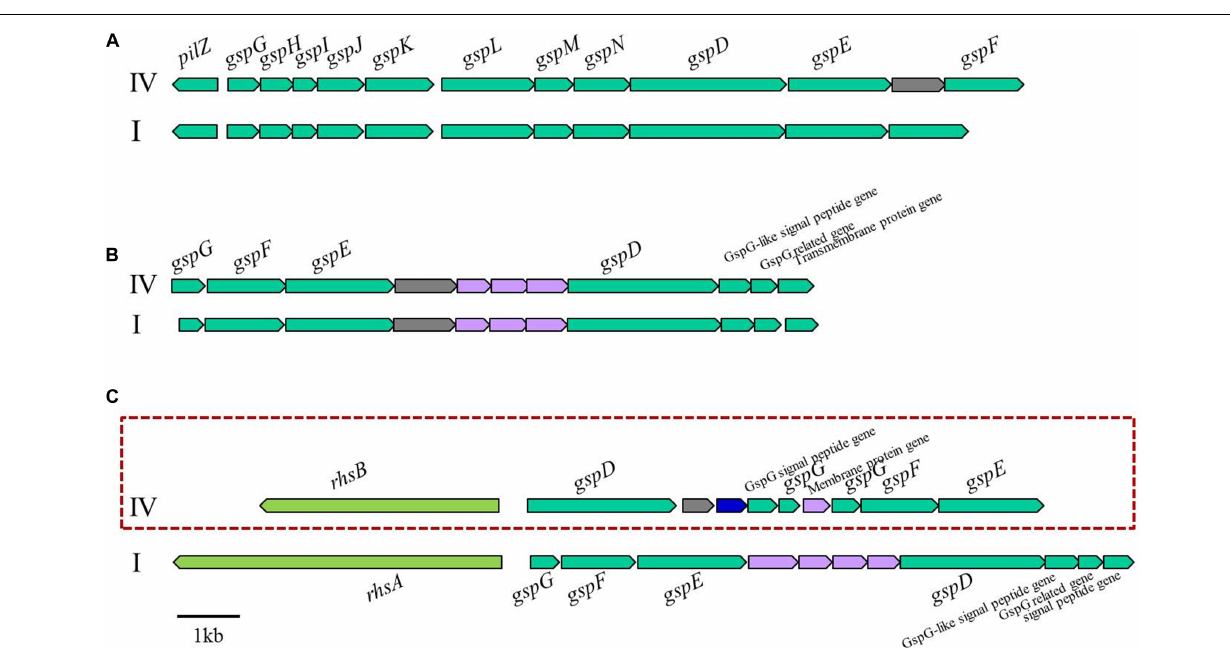
Korean RSSC strains carried the similar gene organization with previously reported RSSC strains for popABC operon driven by a promoter with a PIP box and adjacent hrp cluster. However, while popA ( ripX ) and popB ( ripAB ) were present in all strains, popC ( ripAC ) was not; the popC gene of most strains encoded a protein with 17 LRR motifs, like that of the GMI1000 strain,